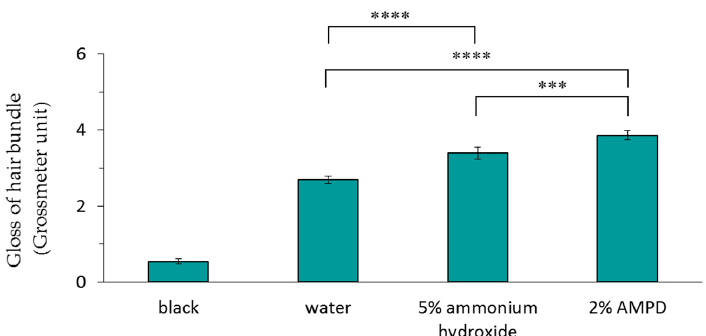
Figure 3. Comparison of the gloss measurements of a human hair bundle immersed in pure water (control), a human hair bundle bleached with H 2 O 2 and 5% ammonium hydroxide, and a human hair bundle bleached with H 2 O 2 and 2% AMPD aqueous solution. The results are expressed as the mean ± standard deviation of five experiments. *** p < 0.001, **** p < 0.0001.